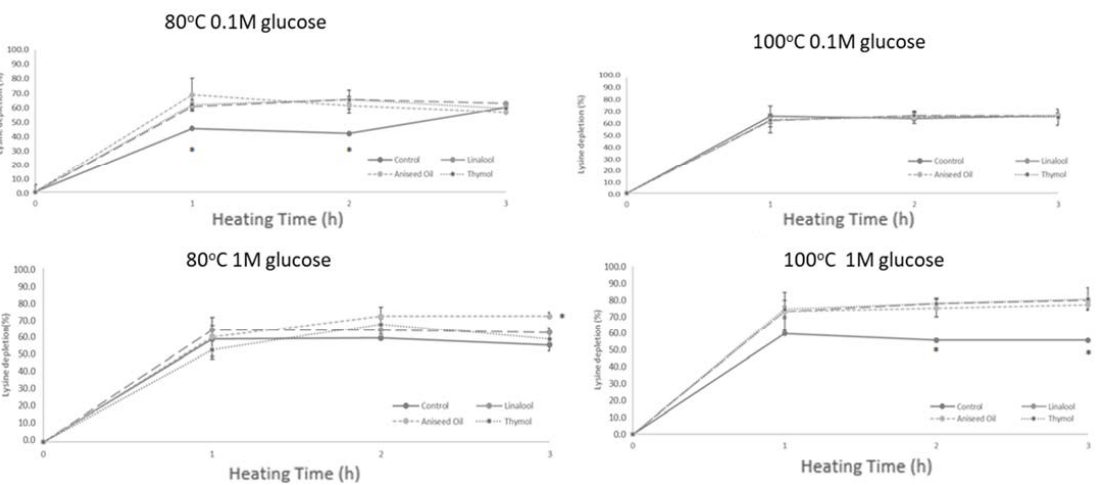
Figure 10. The effect of terpenoid compounds on lysine depletion in heated glucose/lysine solutions at 0.1 M and 1 M glucose at pH 7.2 and 80 °C and 100 °C. * Denotes p < 0.05 control vs. terpenoid